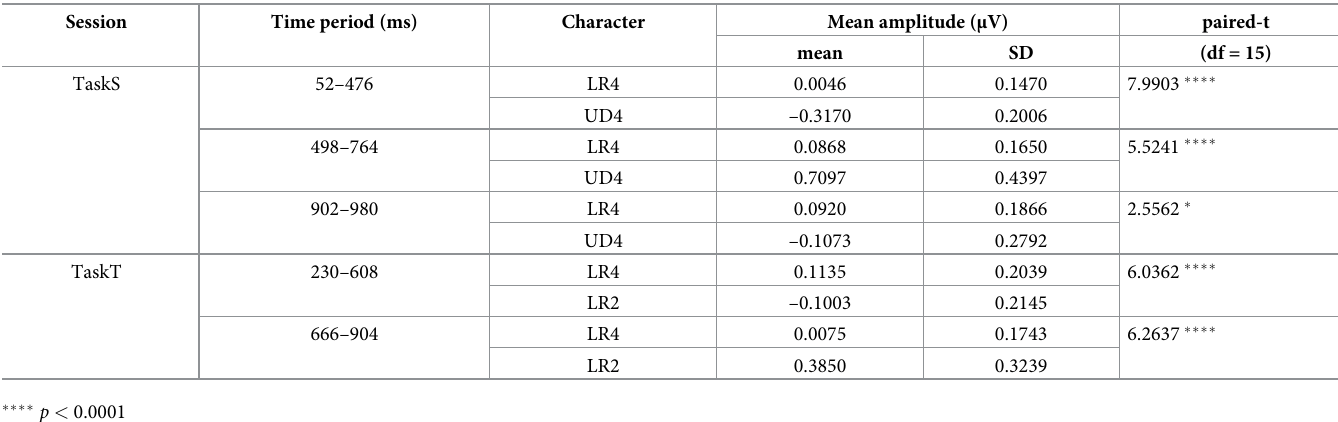
Table 6. Effects of IC2 reflecting conscious detection of abstract structural or tonal pattern.